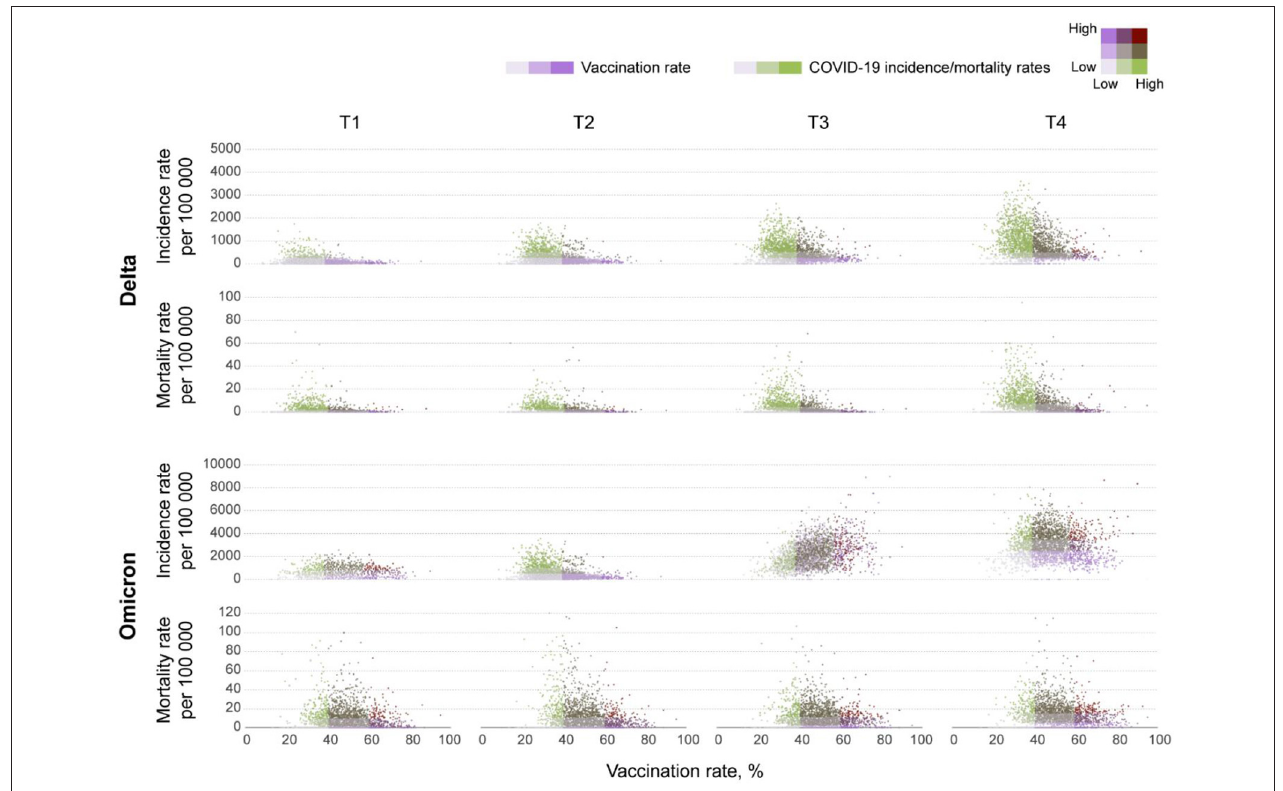
FIGURE 1 | Bivariate scatterplots of the association between vaccination rates and new COVID-19 cases and deaths at the county level in the contiguous U.S. Bivariate scatterplots illustrating the changes of the association between vaccination rates and new COVID-19 cases (incidence rate) and deaths (mortality rate) per 100,000 people at the county level during T1 (July 1–15), T2 (July 16–31), T3 (August 1–15), and T4 (August 16–31) in 2021 for the Delta wave, and T1 (December 1–15), T2 (December 16–31) 2021, T3 (January 1–15), and T4 (January 16–31) in 2022 for the Omicron